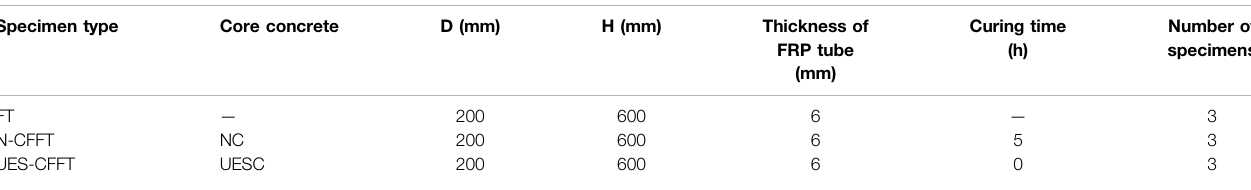
TABLE 4 | Details of test